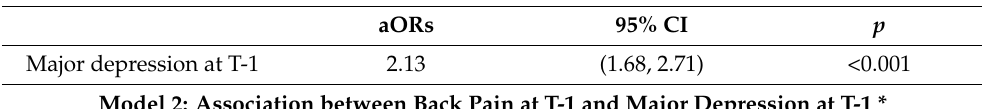
Table 2. Cross-sectional associations with Model 1 and Model 2. Model 1: Association between Major Depression at T-1 and Back Pain at T-1 * aORs 95% CI p Major depression at T-1 2.13 (1.68, 2.71) <0.001 Model 2: Association between Back Pain at T-1 and Major Depression at T-1 * aORs 95% CI p Back pain at T-1 2.11 (1.66, 2.69)